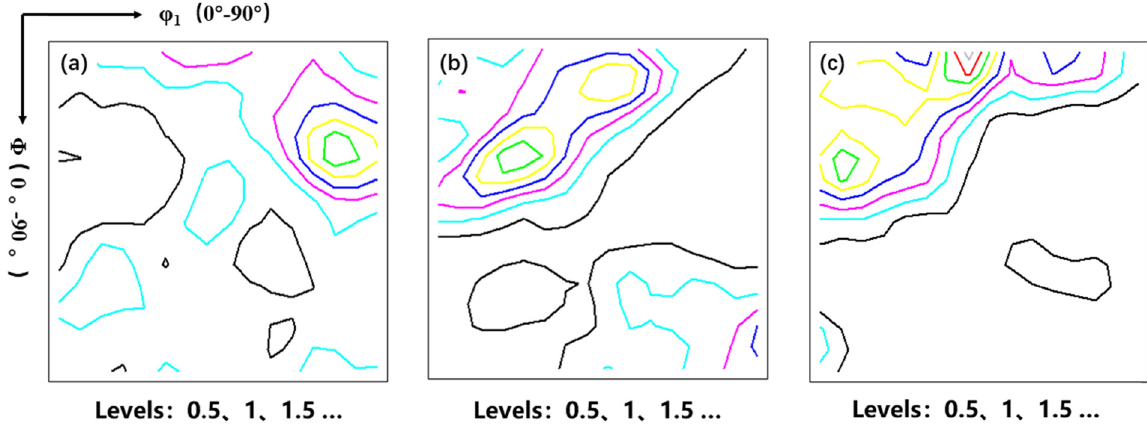
Figure 14: ODF diagram of φ 2 = 45° at di ff erent thicknesses of hot - rolled sheet containing Y: ( a ) S = 0; ( b ) S = 1/4; and ( c ) S = 1/2.